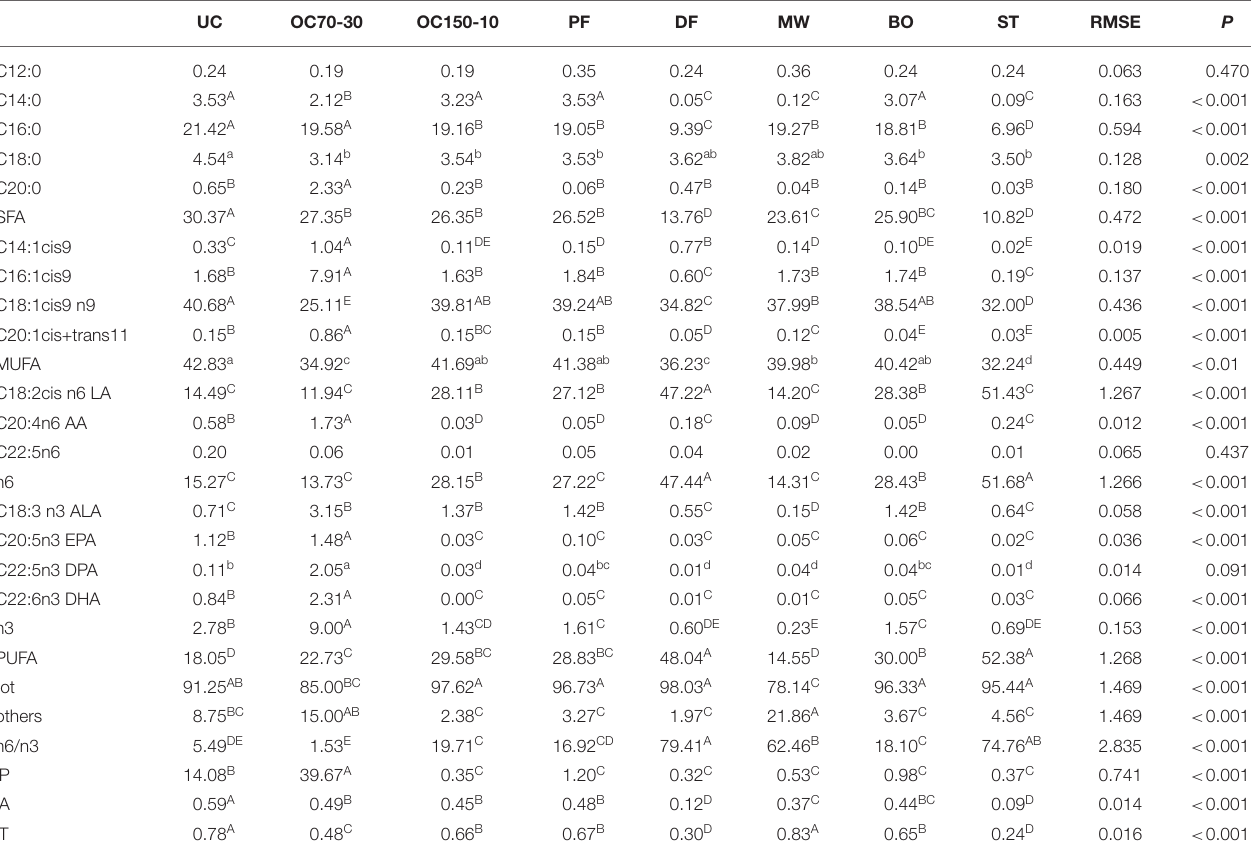
TABLE 2 | Fatty acid profile (%) of uncooked larvae and larvae cooked with different techniques. UC OC70-30 OC150-10 PF